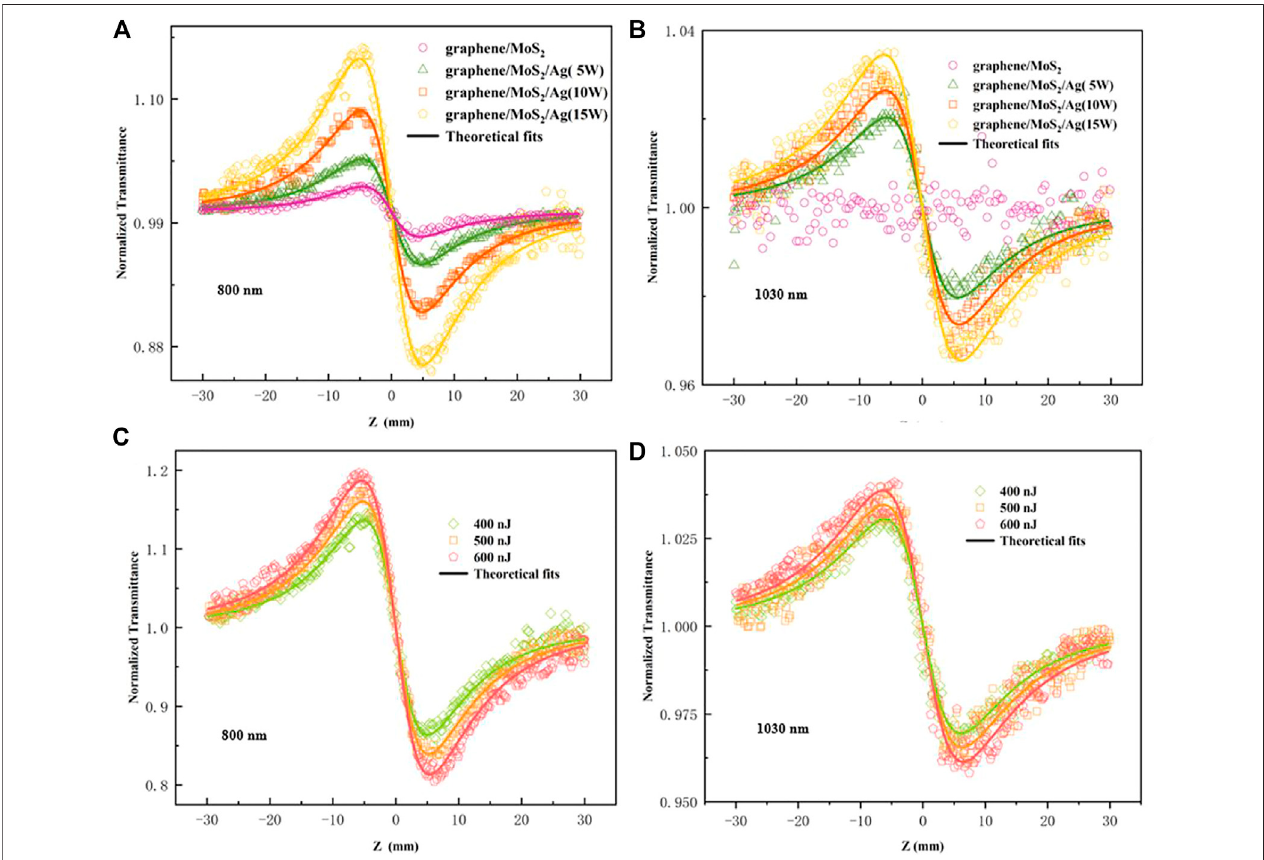
FIGURE 8 | The CA Z-scan signal of A and B thin fi lms at 800 (A) and 1,030 nm (B) . The CA Z-scan signals of B 3 thin fi lm at 800 (C) and 1,030 nm (D) under different excitation conditions.